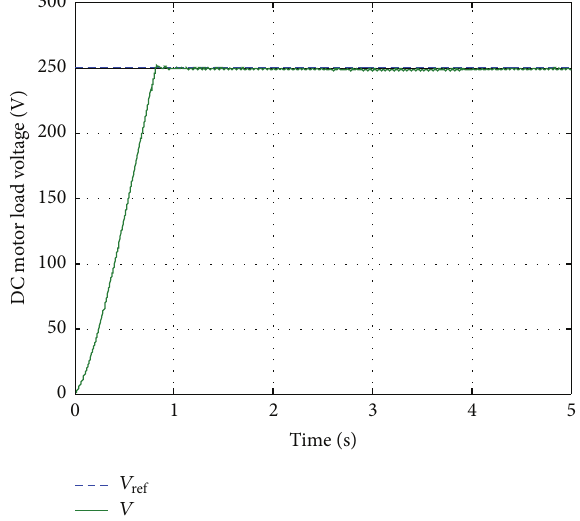
Figure 12: Speed-time waveform.